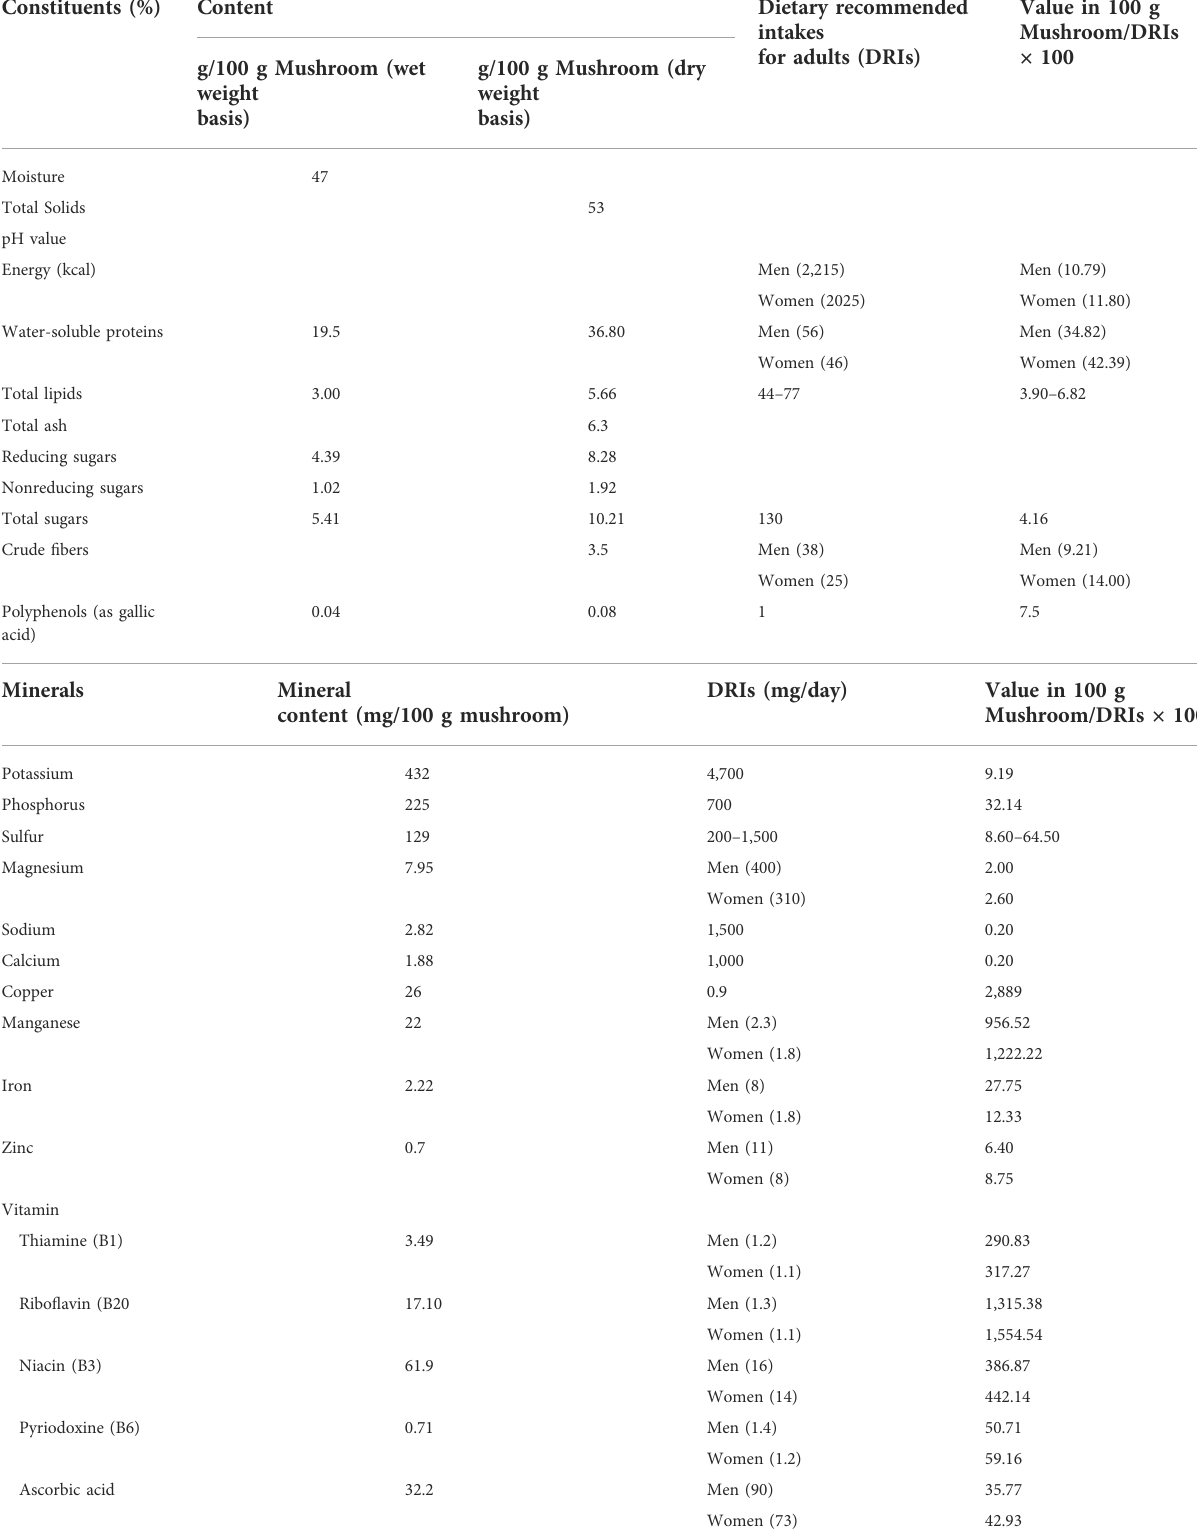
TABLE 4 Nutritional pro fi le, mineral and vitamin constituents of Ganoderma lucidum (El Sheikha,